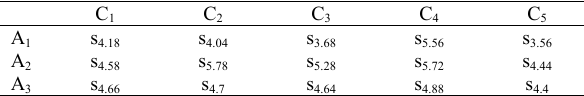
Table 6 The collective assessments of criteria versus alternatives.